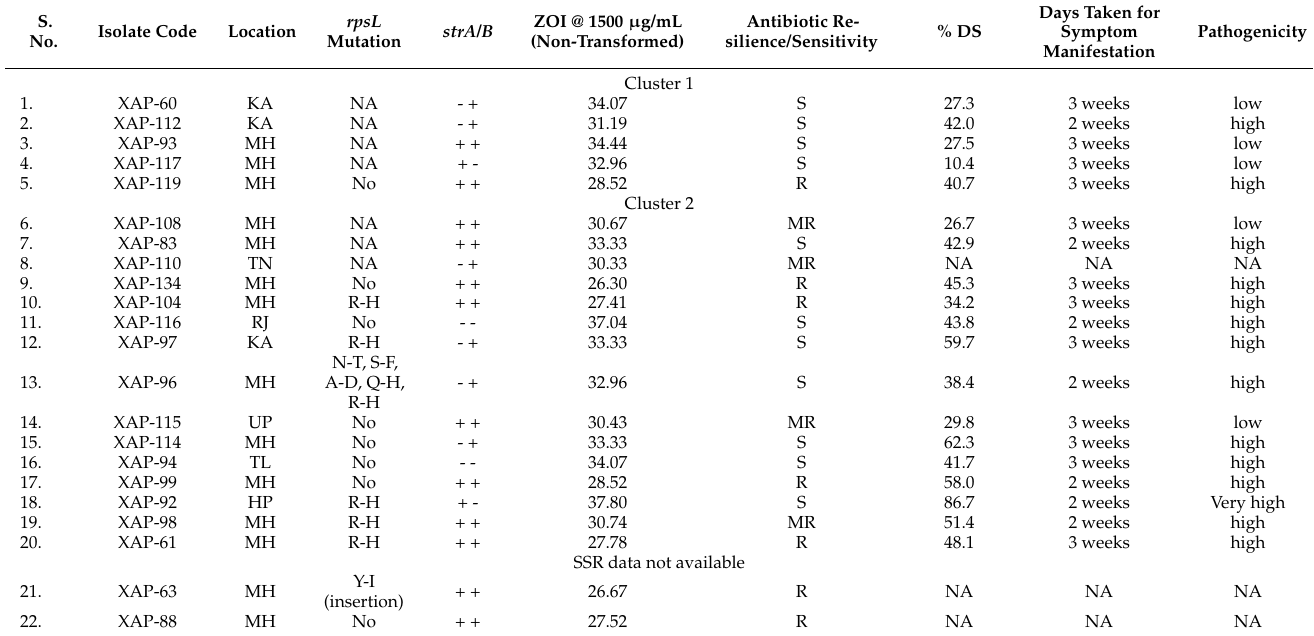
Table 4. Correlation between different parameters of Xap isolates investigated in the current study.